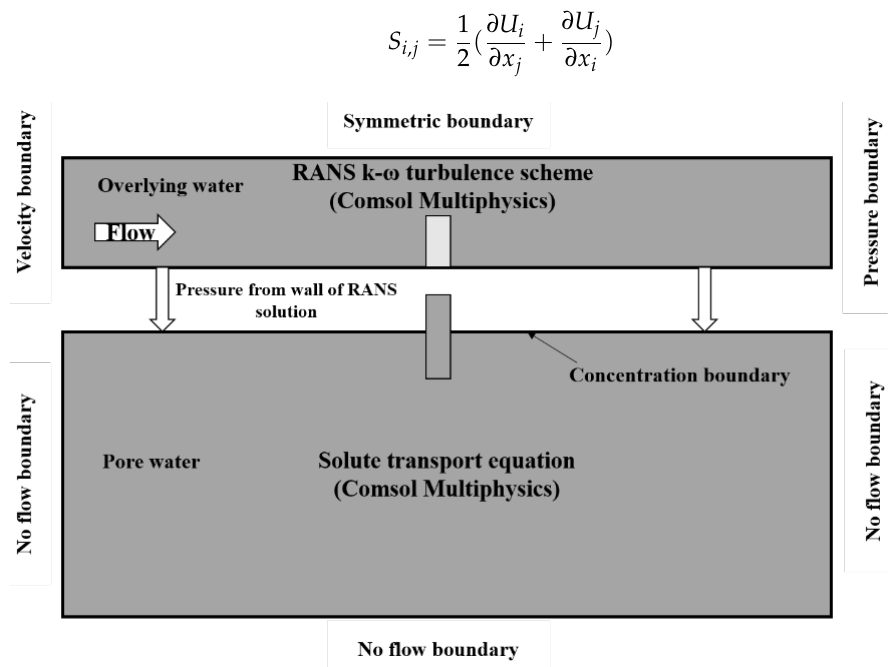
Figure 2. The conceptual model for the hyporheic zone in the experiment revised from references [11] and [33].